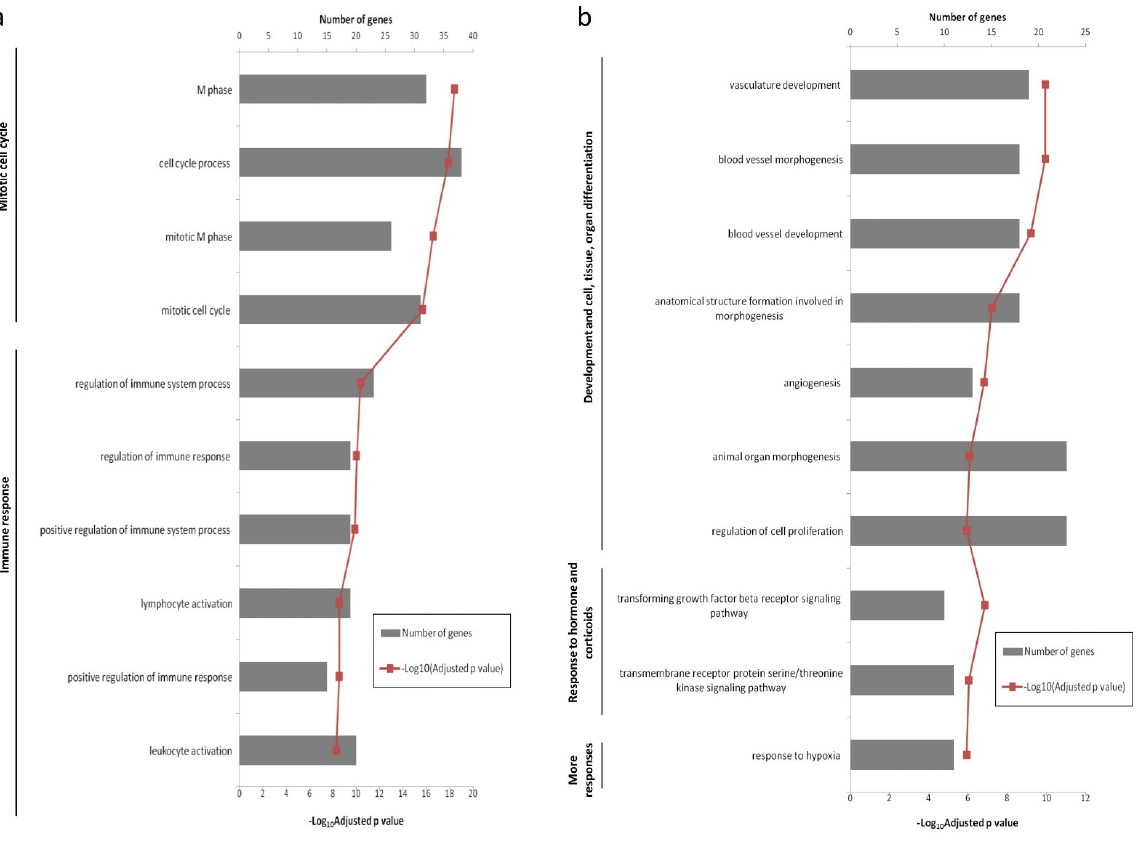
Figure 3. The Top 10 significant enriched GO terms in the Lesions group relative to the Seronegative group. ( a ) Up-regulated genes ( b ) Down-regulated genes.